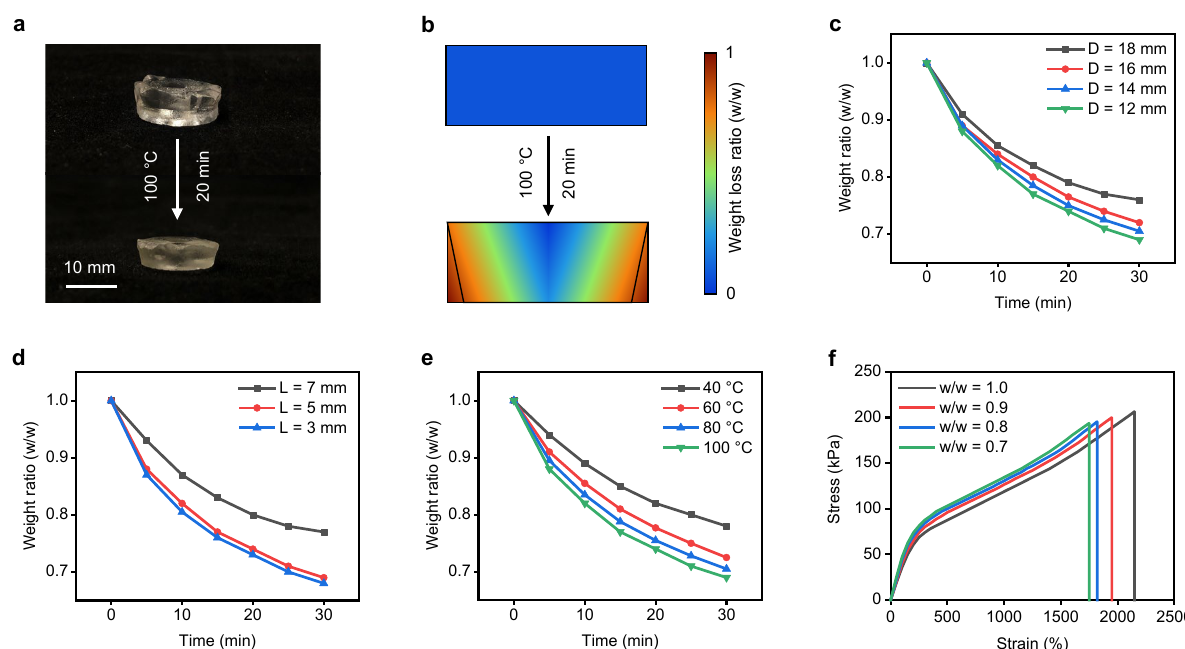
Figure 7. PAHV dehydration kinetics. ( a ) Real-time photos demonstrating PAHV’s dehydration kinetics ( D = 12 mm, L = 5 mm) when heated at 100 ◦ C for 20 min. ( b ) Schematic showing the dehydration profile of the PAHV during actuation. ( c ) PAHV weight ratio change ( L = 5 mm) for different diameters (12–18 mm) when actuated at 100 ◦ C. ( d ) PAHV weight ra- tio change ( D = 12 mm) for different lengths (3–7 mm) when actuated at 100 ◦ C. ( e ) PAHV weight ratio change ( D = 12 mm, L = 5 mm) when actuated at different temperatures (40–100 ◦ C). ( f ) PAHV extensometry performance at different weight ratios (w/w = 0.7, 0.8, 0.9, and